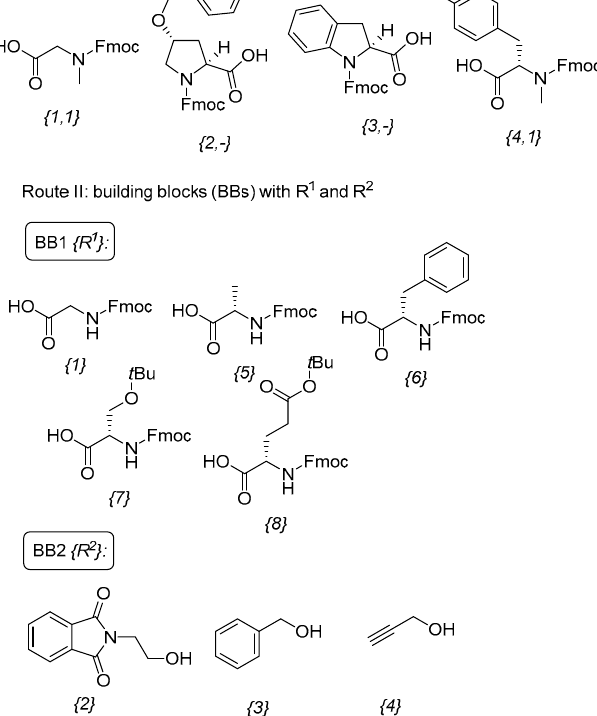
Figure 1. List of building blocks (BBs) used in synthesis.